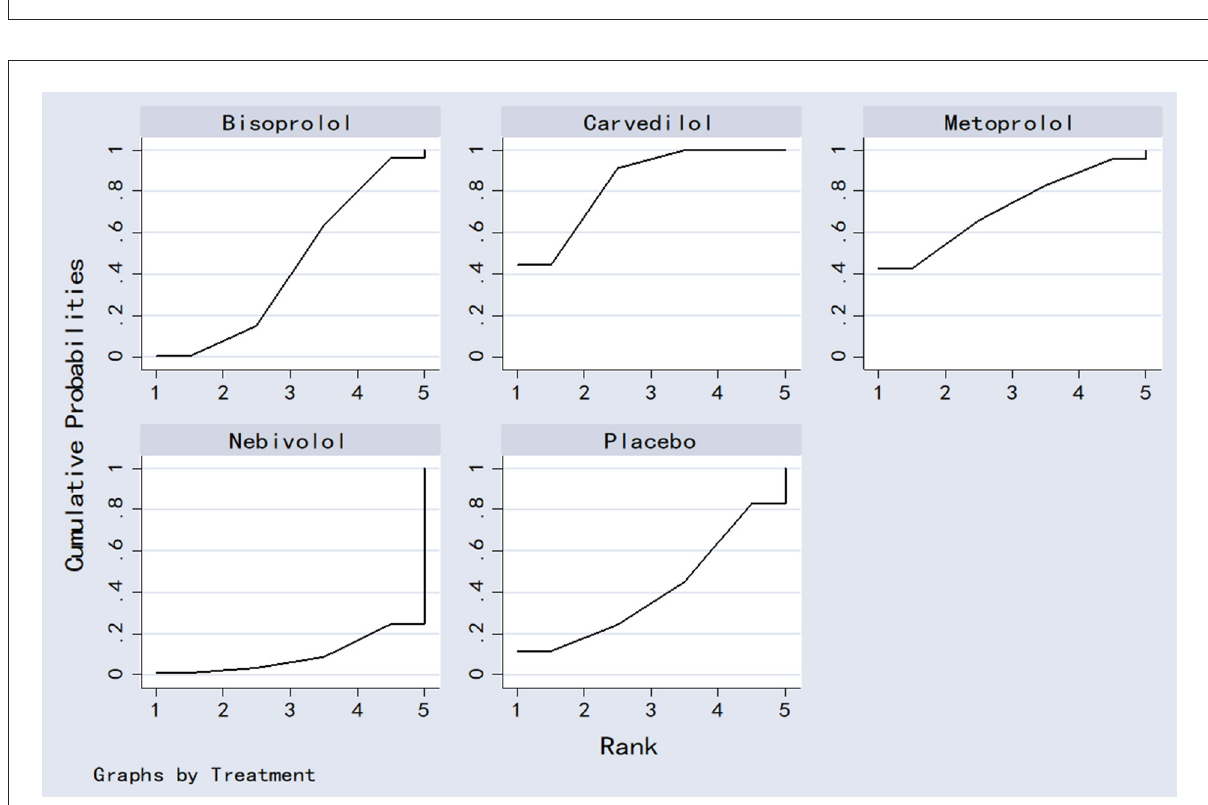
FIGURE9 The surface under the cumulative ranking curve